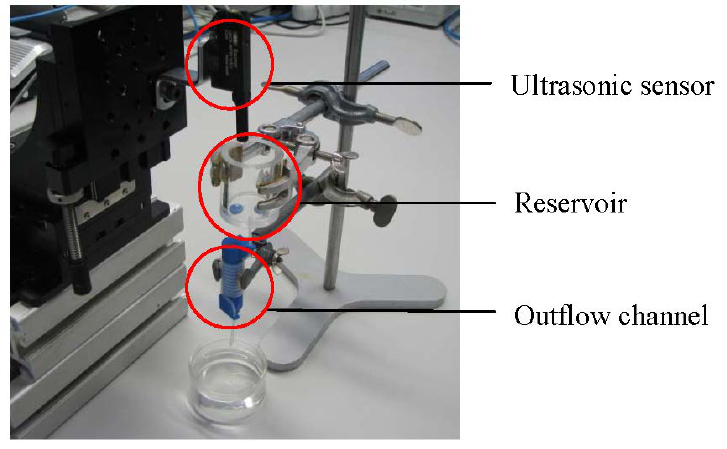
Figure 6. Sensor based analysis of flow rate—outflow